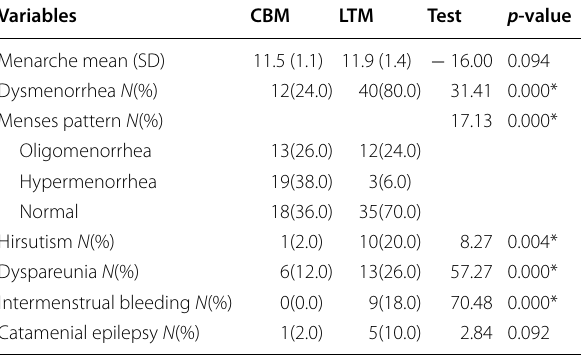
Table 2 Showing comparison of menstrual characteristics of WWE on CBM and LTM